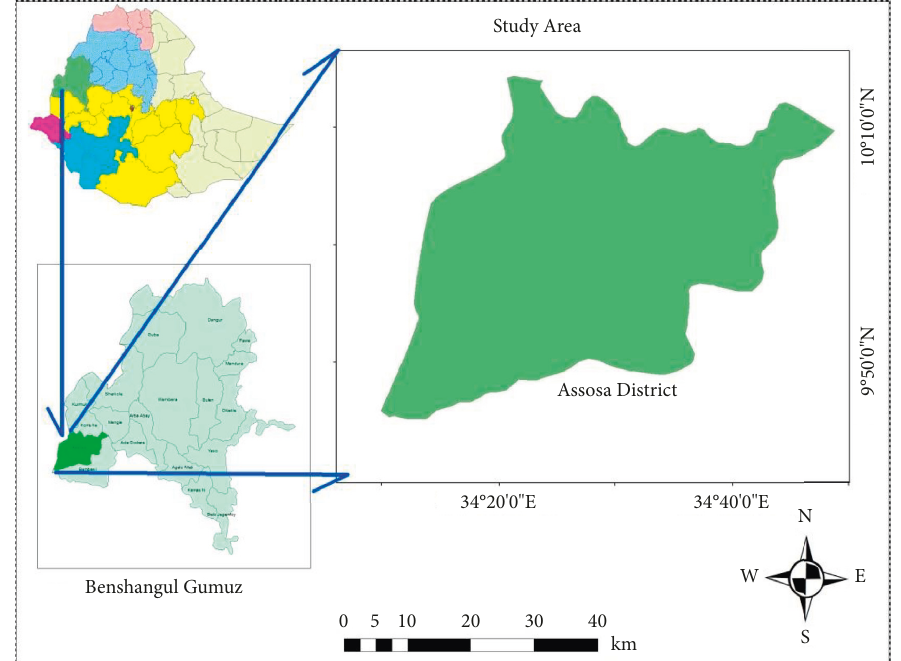
Figure 1: Map of the study